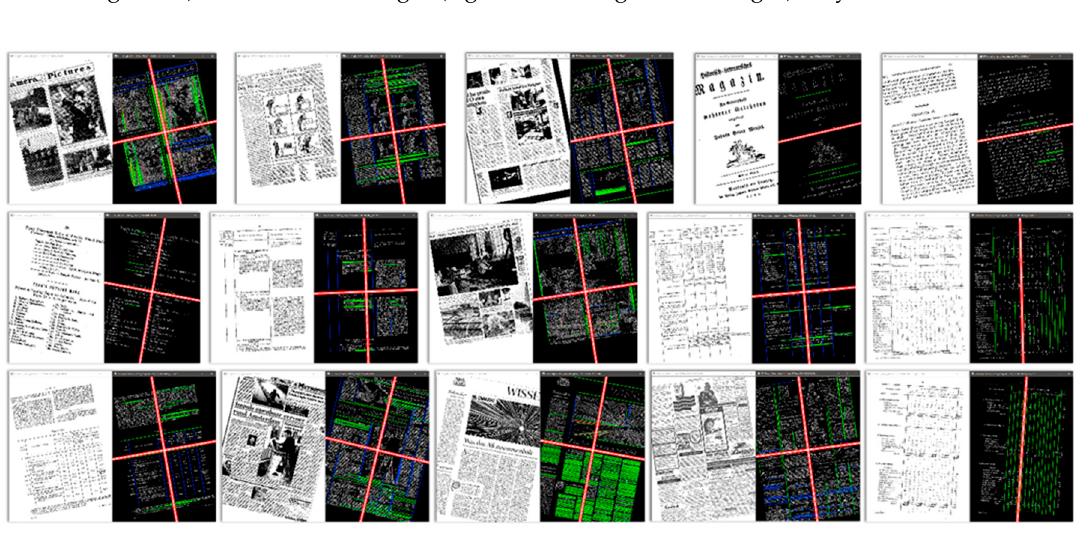
Figure 6. Document orientation detection using the detected lines in the spatial domain (black background), the algorithm performed on various documents (white background).